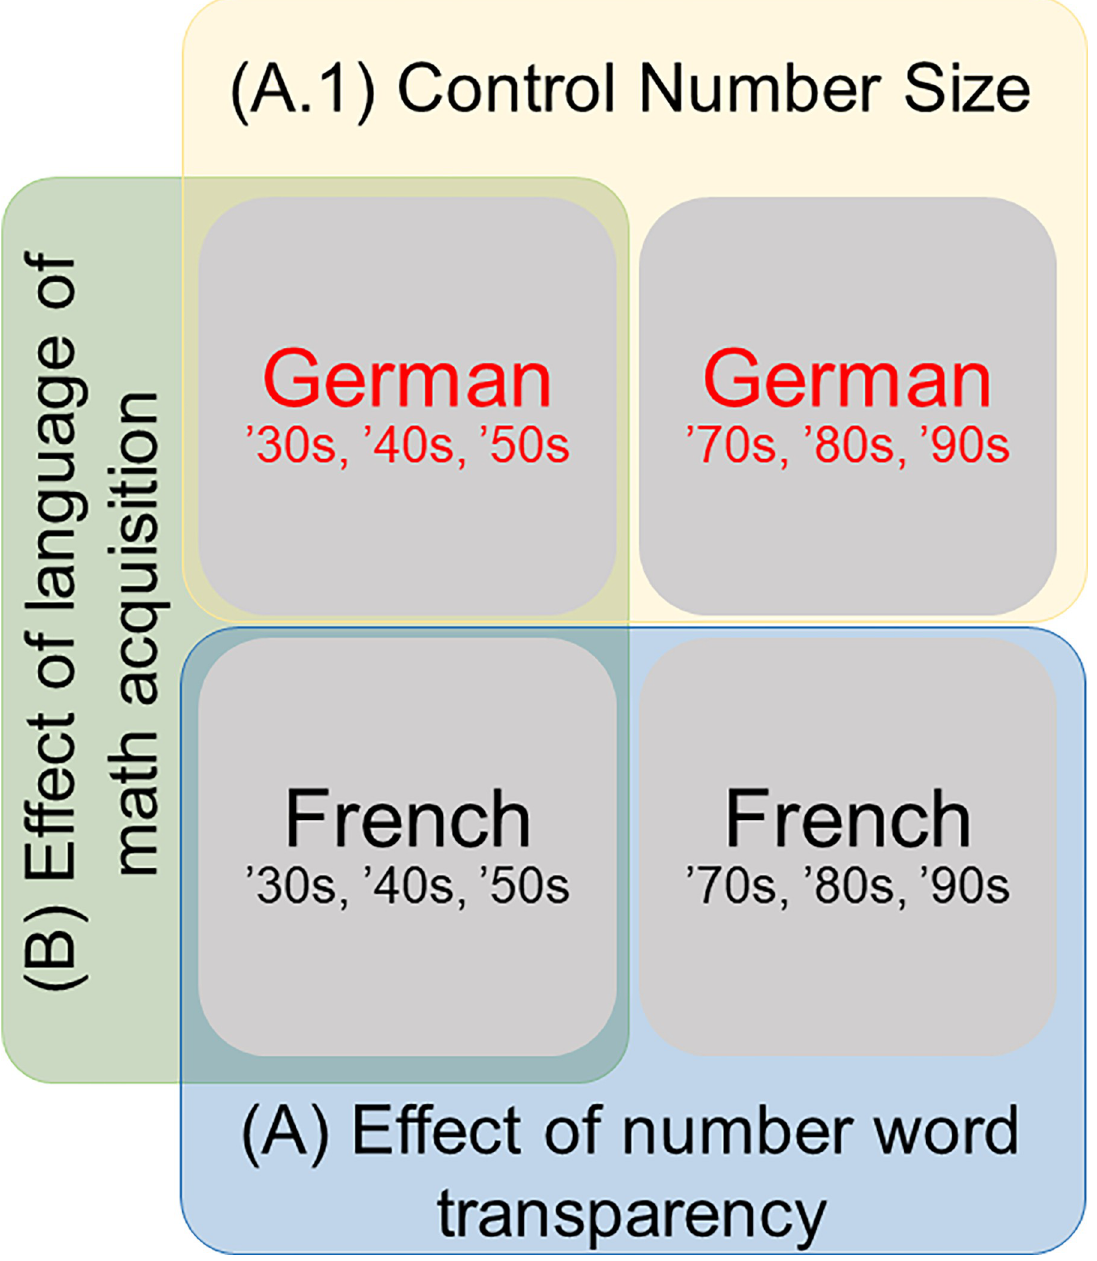
Fig 1. Venn diagram of the design rationale. Design rationale of the comparisons on the different hypotheses of number word transparency (A) and age of math acquisition